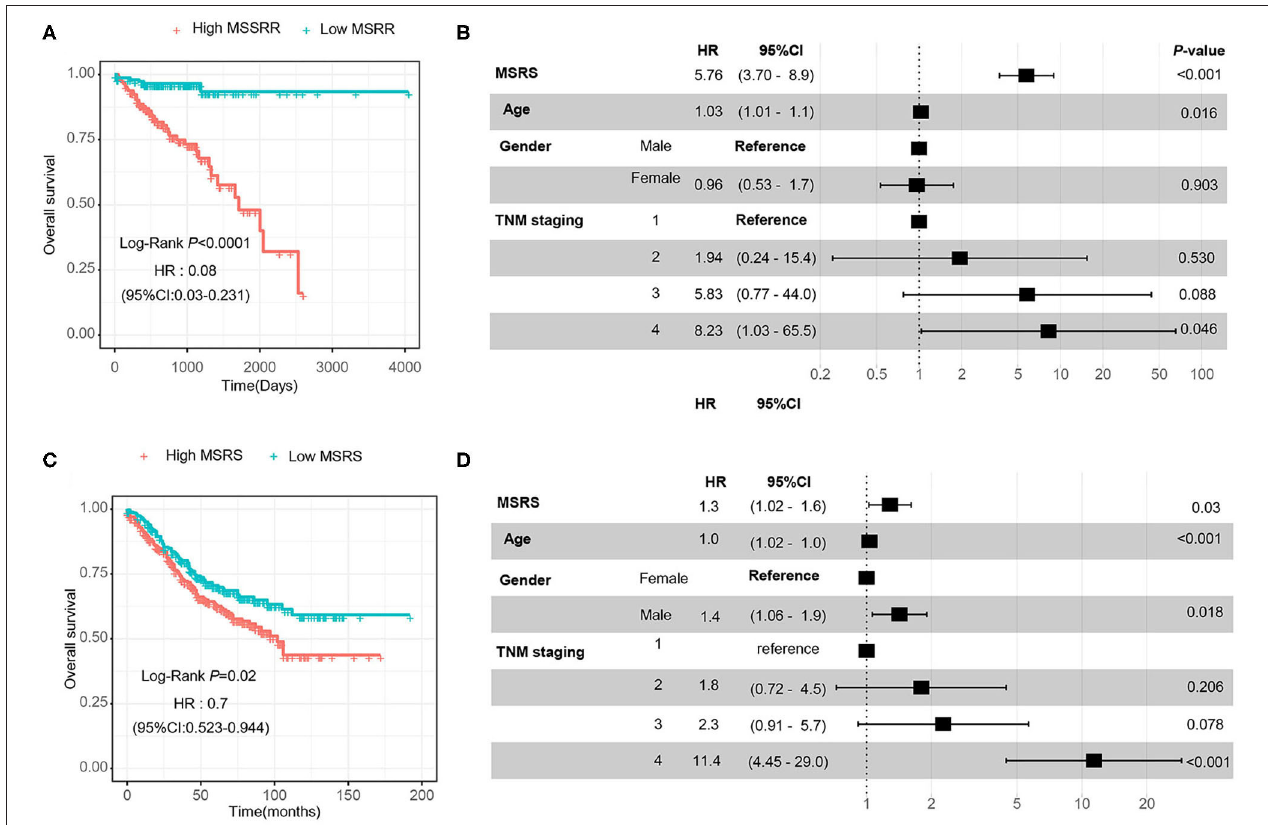
FIGURE 5 | Construction of the microsatellite-related gene signature (MSRS) and its discrimination ability. We selected the penalty parameter when the partial likelihood deviance is the least by 10-fold cross-validation (A) and 24 nonzero coefficient genes were remained (B) . The waterfall plot of the MSRS (C) ranking from smallest to largest. The time-dependent receiver operating characteristic (ROC) curves (D) indicate that the MSRS has favorable discrimination power even over TNM